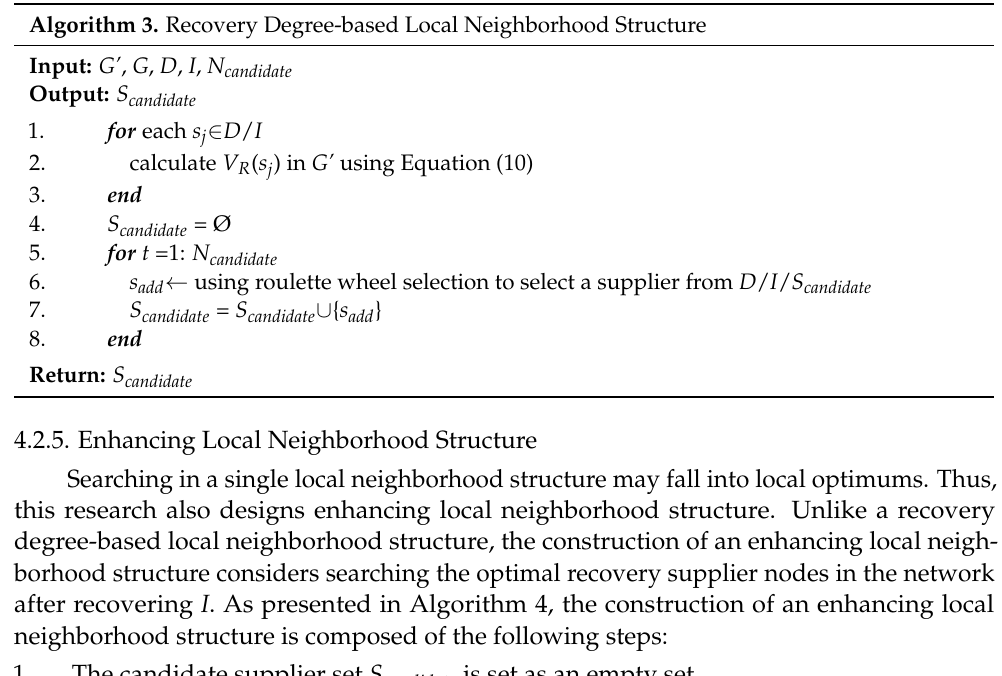
Algorithm 4. Enhancing Local Neighborhood Structure